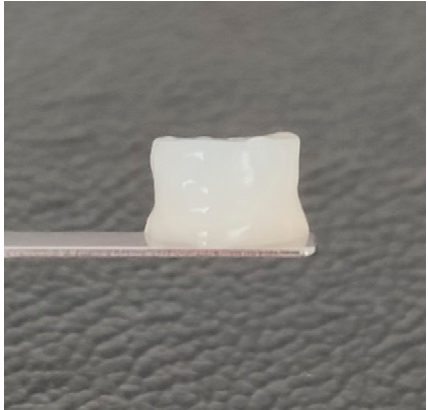
Figure 5. Hydrogel of formulation L (70% GelMA, 15% CSMA, 15% HAMA). An illustrative example of the produced hydrogels.